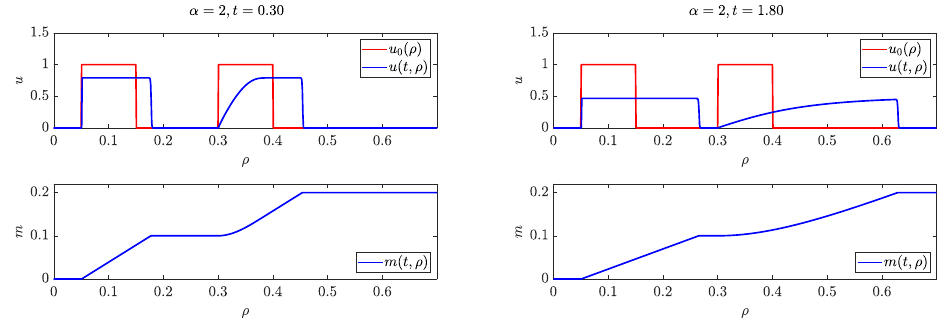
Fig. 5: Solutions with u 0 given by two characteristics. Computed with the numerical scheme for m in Section 5 reproducing the exact solution up to approximation error. The function u = m